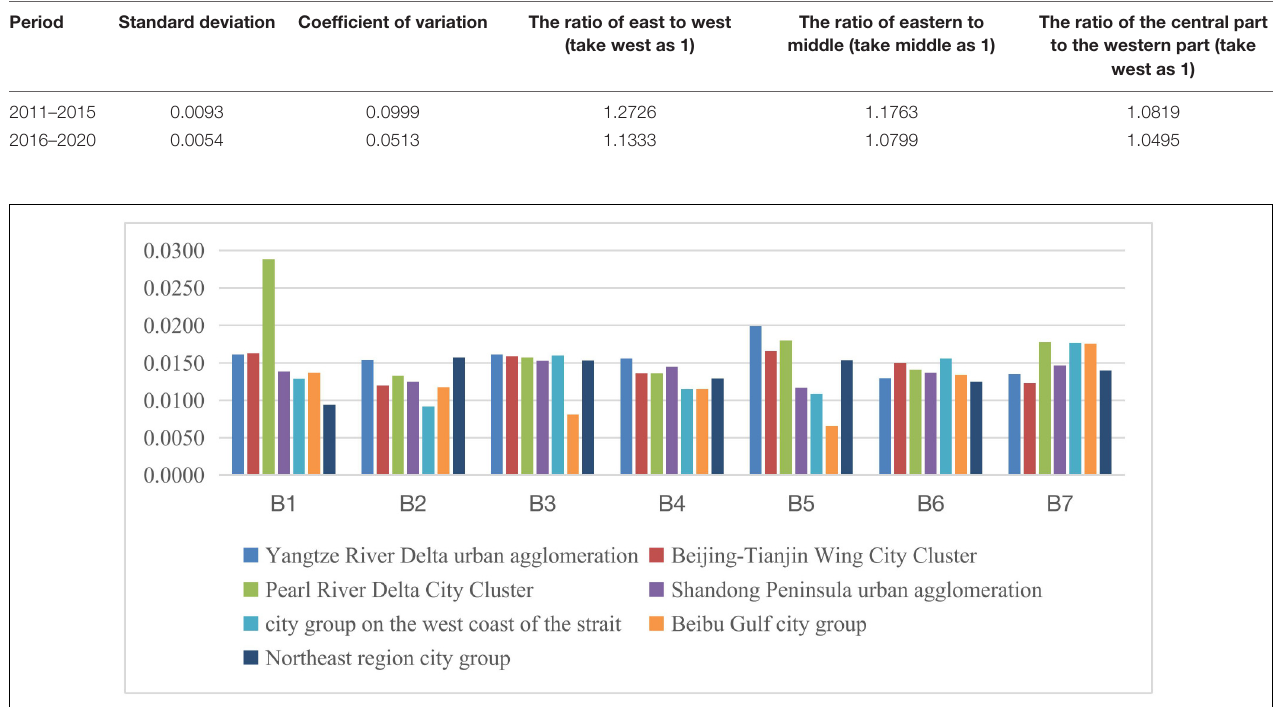
TABLE 7 | The social development gap in China ’s eastern, middle, and western regions. Period Standard deviation Coefficient of variation The ratio of east to west